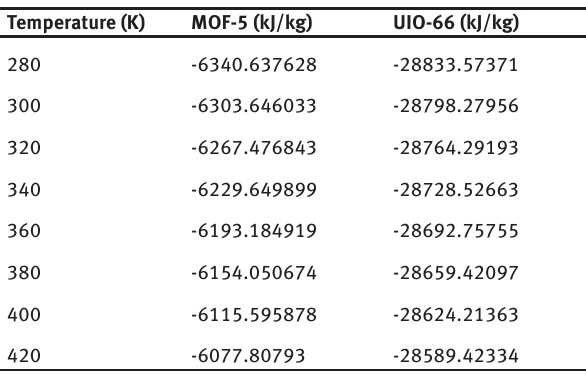
Table 1: Thermodynamic Energies of MOF-5 and